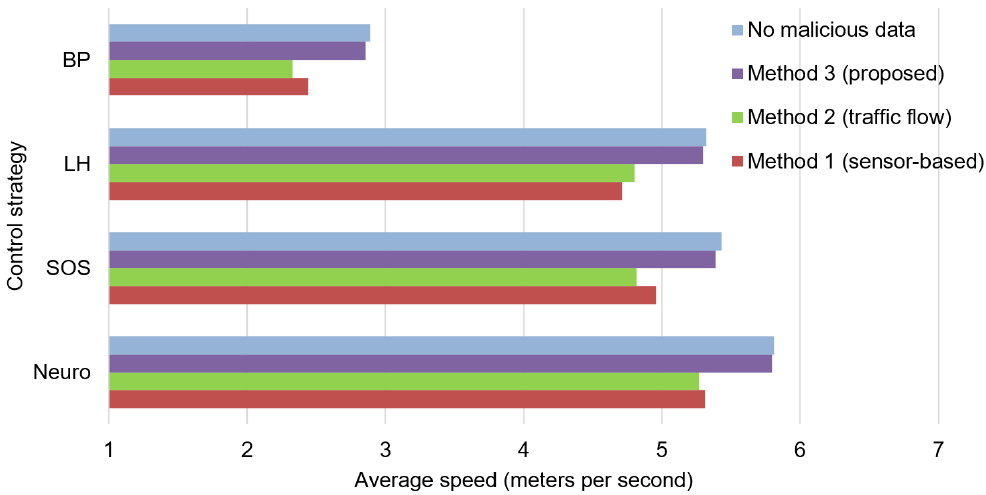
Figure 13. Average speed of vehicles for different signal control strategies with and without detection of malicious